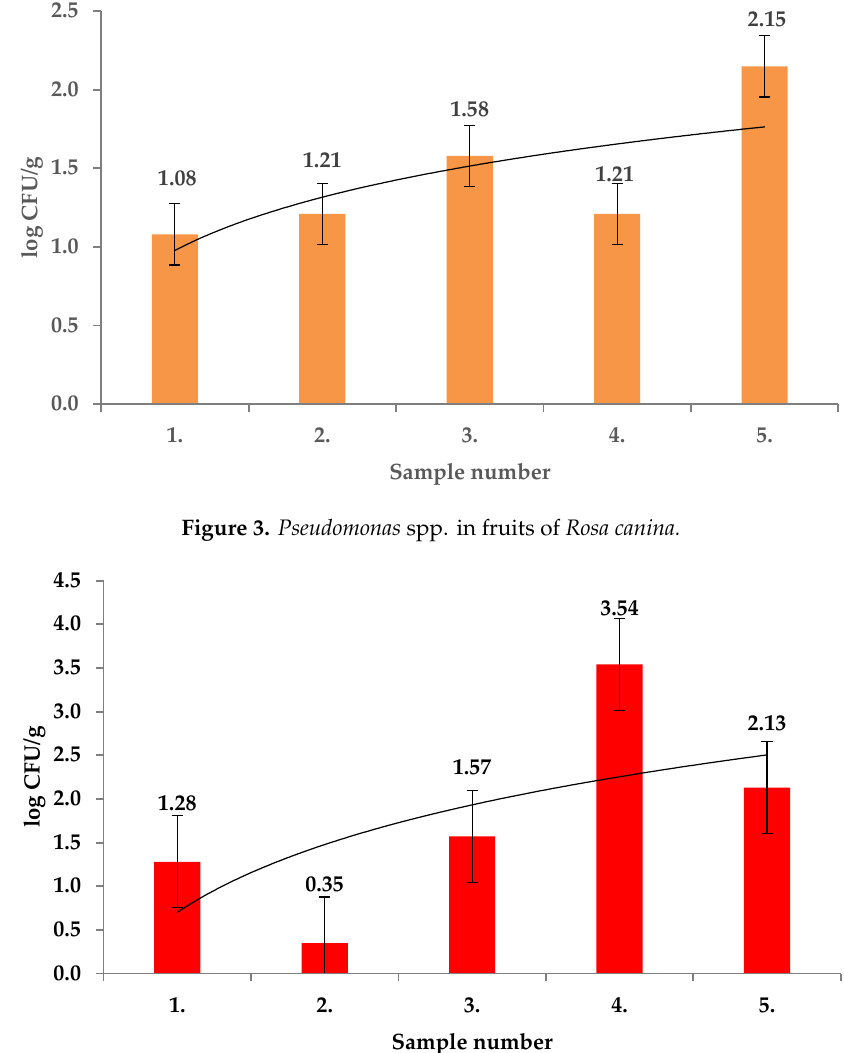
Figure 4. Enterobacteriaceae in fruits of Rosa. canina .